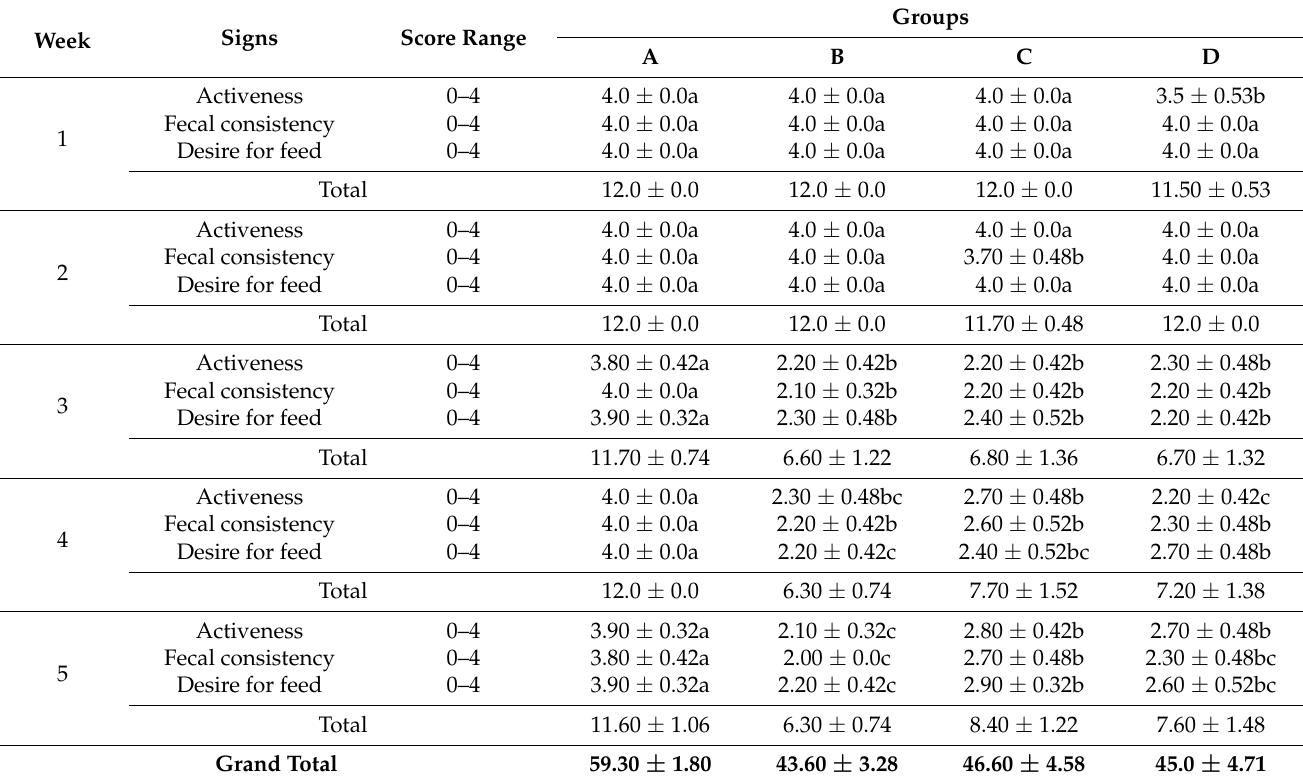
Table 2. Scoring results of various clinical signs and behavioral symptoms in birds.